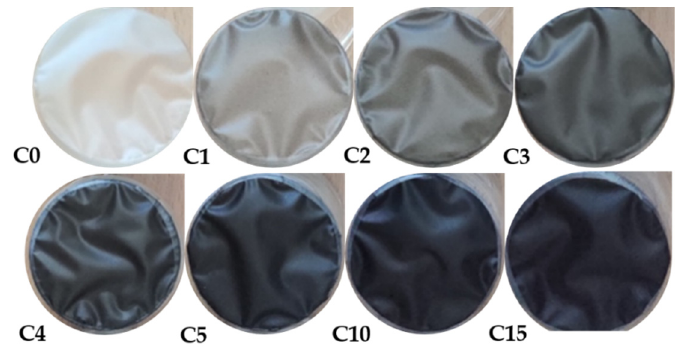
Figure 1. Image of starch composite film-covered vessels for the WVP test.